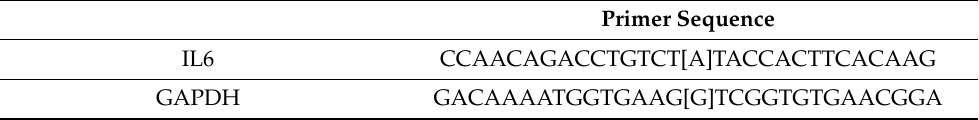
Table 2. The primer sequences used for real-time PCR